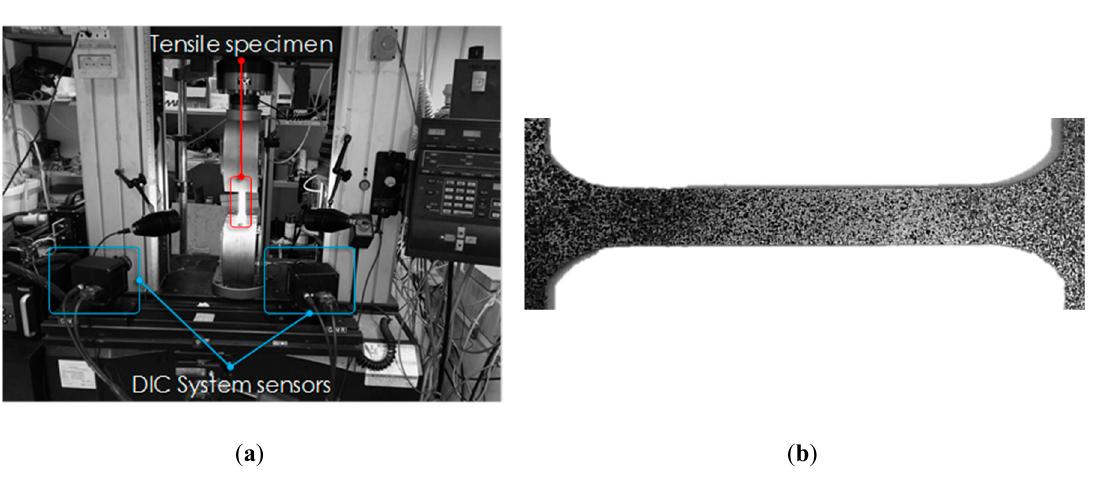
Figure 3. Laser Heat Treatment (LHT) tests on AA6082-T6 tensile specimens: ( a ) detailed view of the laser heating head, ( b ) experimental setup.